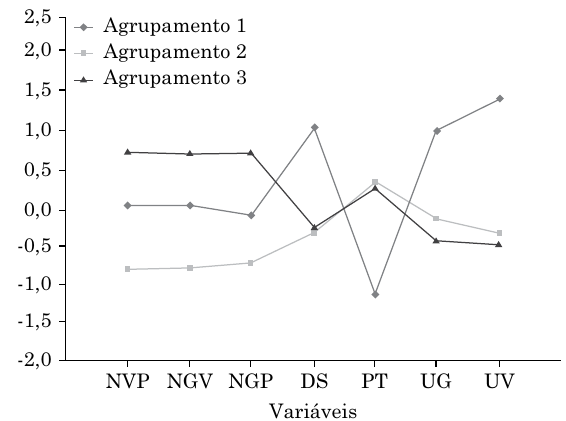
Figura 4. Médias padronizadas dos componentes da produção do feijão (NVP: número de vagens por planta, NGV: número de grãos por vagem e NGP: número de grãos por planta) e alguns atributos físicos do solo (DS: densidade do solo; PT: porosidade total; UG: umidade gravimétrica; e UV: umidade volumétrica) para cada grupo, segundo análise de agrupamentos não hierárquica k-means